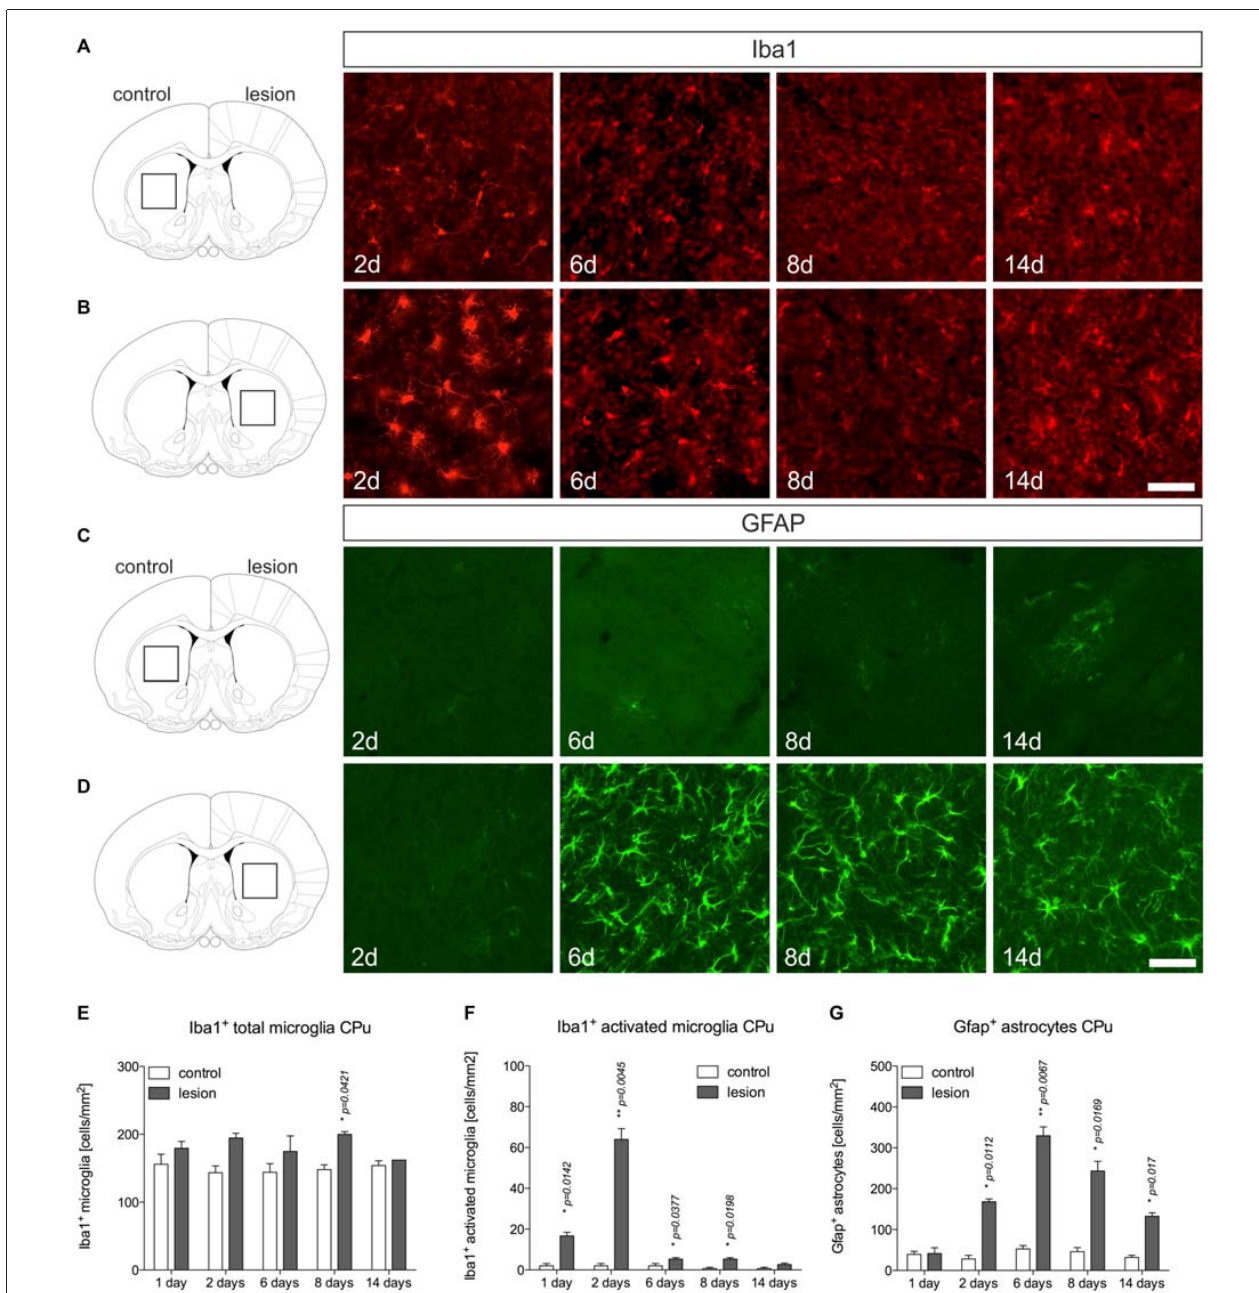
FIGURE 3 | Microglia and astroglia reactivity in the CPu after 6-OHDA injections. Microglia showing ramified morphologies could be detected after Iba1-immunohistochemistry in the unlesioned CPu at all time-points analyzed (A) . Two days after 6-OHDA injections a strong microglia reactivity was observed in the lesioned CPu, which was not longer visible at 6 days, 8 days and 14 days after injection of 6-OHDA (B) . Immunohistochemistry for Gfap showed that virtually no Gfap + astrocytes were present in the CPu on the control side at all time-points analyzed (C) . Comparable to the observations in the lesioned SN, strong increases in Gfap-immunoreactivity and numbers of Gfap + astrocytes in the CPu were observed starting from 6 days after injection of 6-OHDA and again, persisting until 14 days (D) . Scale bars indicate 75 µ m. Quantifications of total microglia (E) , activated microglia (F) and Gfap + astrocytes (G) in the CPu on control and lesioned sides. Data are given as numbers/mm 2 (mean ± SEM) from three animals per time-point. p -values derived from student’s t -test are ∗ p < 0.05 and ∗∗ p <